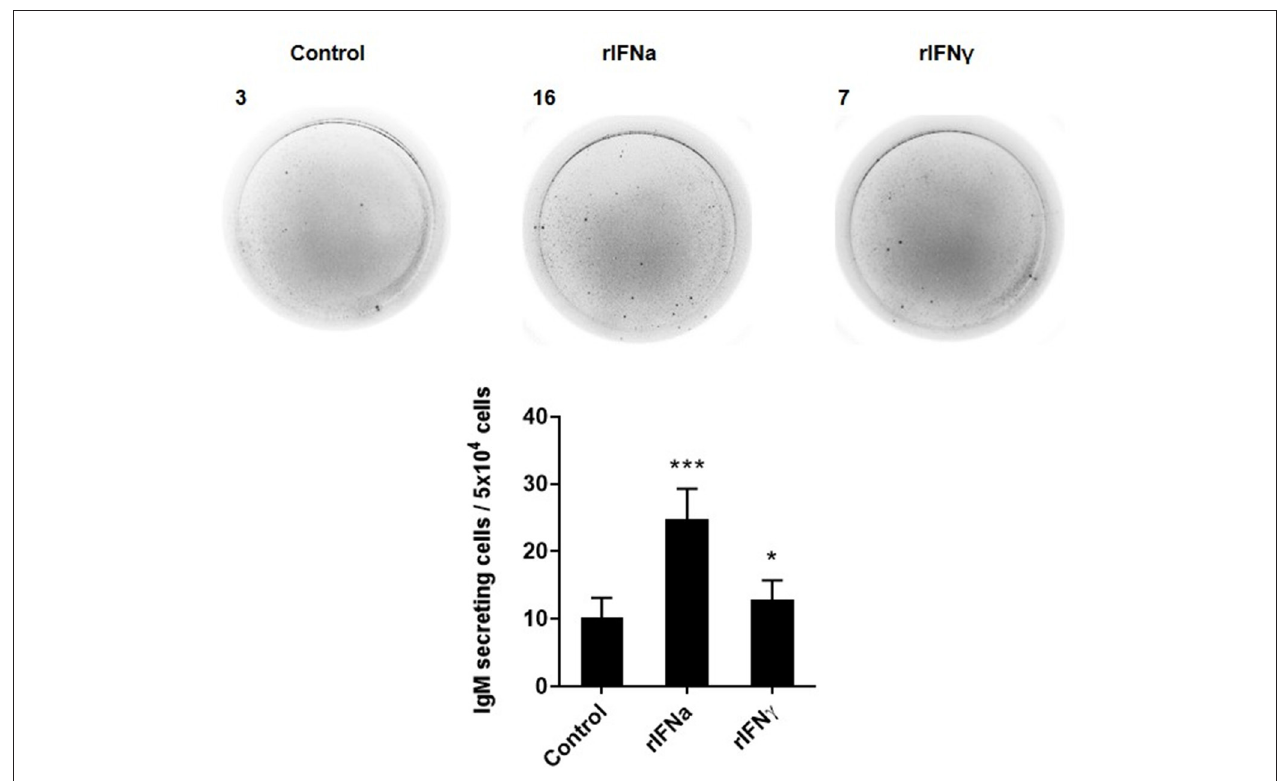
FIGURE 5 | Effect of type I and type II IFNs on the differentiation of IgM + IgD + B cells to IgM-secreting cells. PBLs were treated with 50ng/ml rIFNa, 20ng/ml rIFN γ or media alone (control) and incubated for 72h at 20 ◦ C. Thereafter, cells were added to ELISPOT plates, previously coated with anti-IgM mAb (2 µ g/ml), and incubated for a further 24h. The number of IgM-secreting cells was then detected as described in Materials and Methods. Representative wells from one individual are shown along with the quantification of spot-forming cells (mean + SEM; n = 12). Asterisks denote significant differences between samples treated with rIFNs and control samples (* P ≤ 0.05, *** P ≤